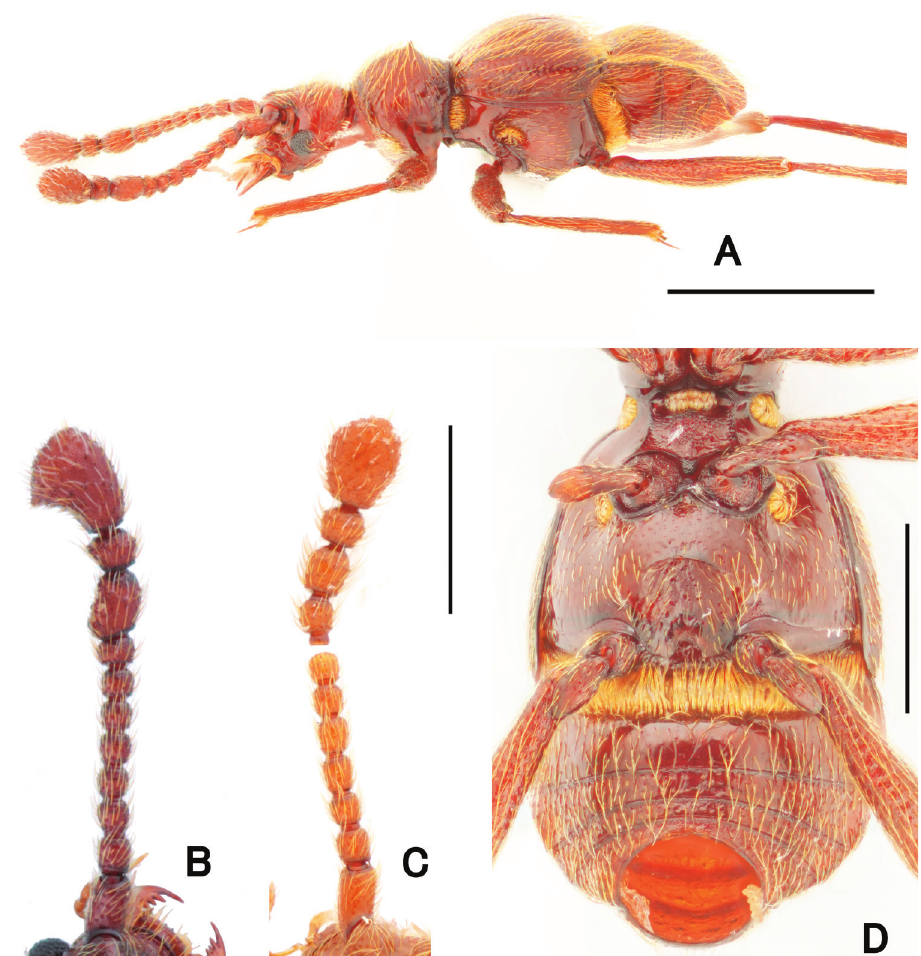
Figure 6. Morphological details of Pseudophanias nakanoi A habitus in lateral view B male antenna C female antenna D male metaventrite. Scale bars: 1.0 mm ( A ); 0.5 mm ( D ); 0.2 mm ( B, C